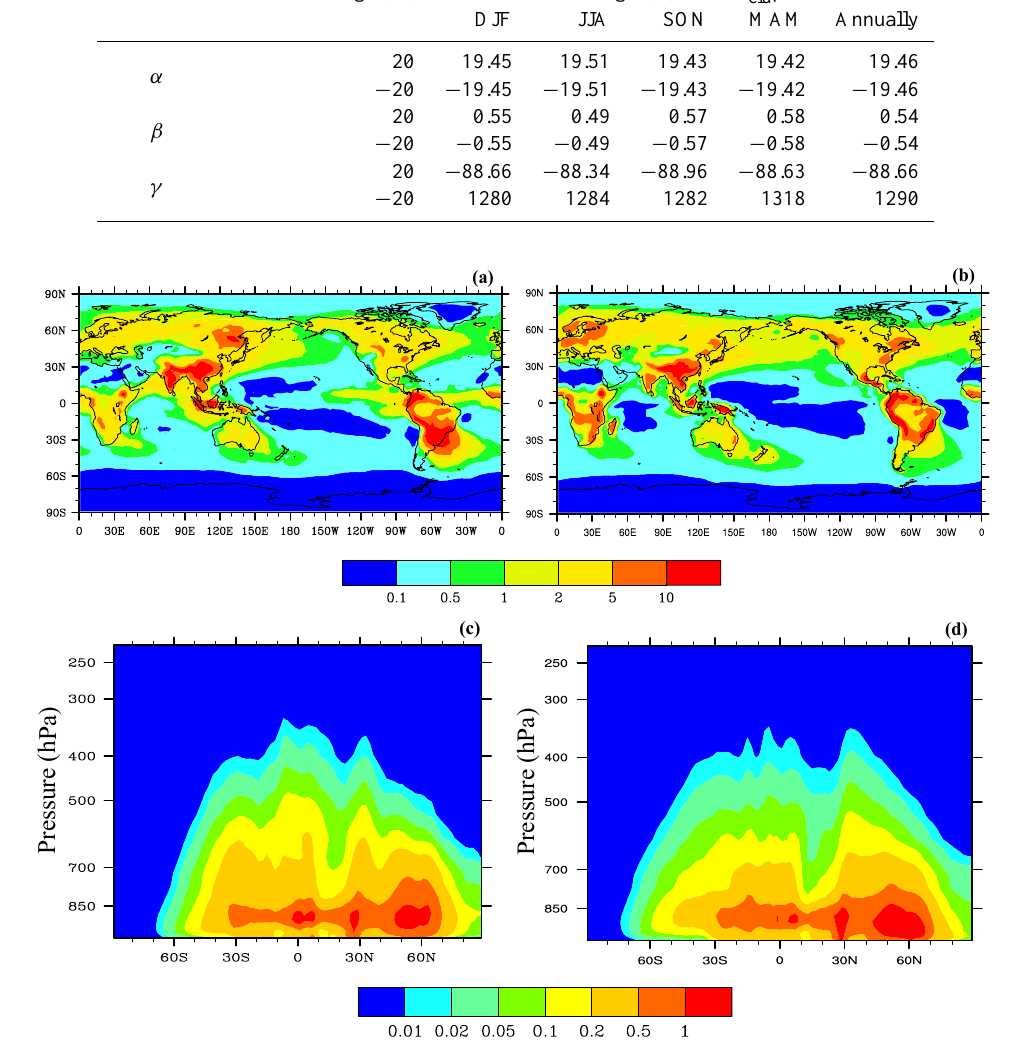
Fig. 4. Process-based (a, c) and parameterized (b,d) annual averaged column production (a,b, unit: ngm − 2 s − 1 ) and zonal mean production ( c, d , unit: pgm − 3 s − 1 ) of SOA from cloud